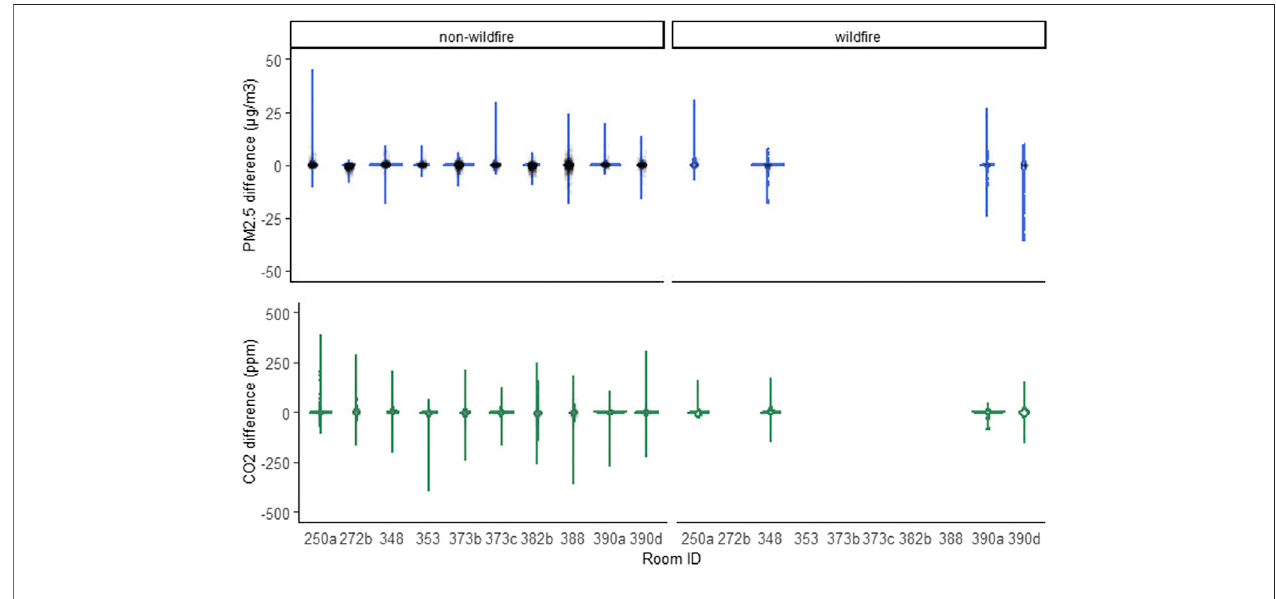
FIGURE 9 | Hourly room PM 2.5 and CO 2 deviation from the building-level median.